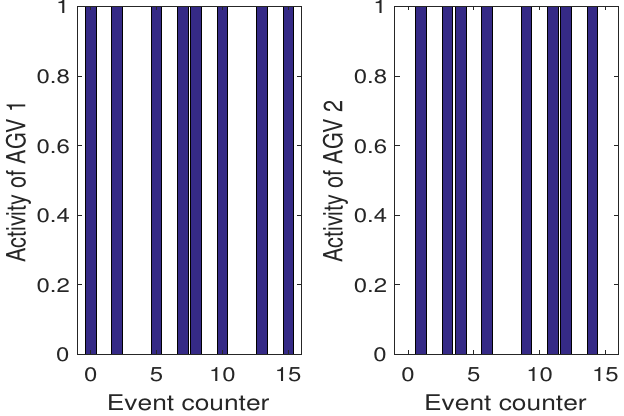
Figure 16. Scenario 1: Activities of